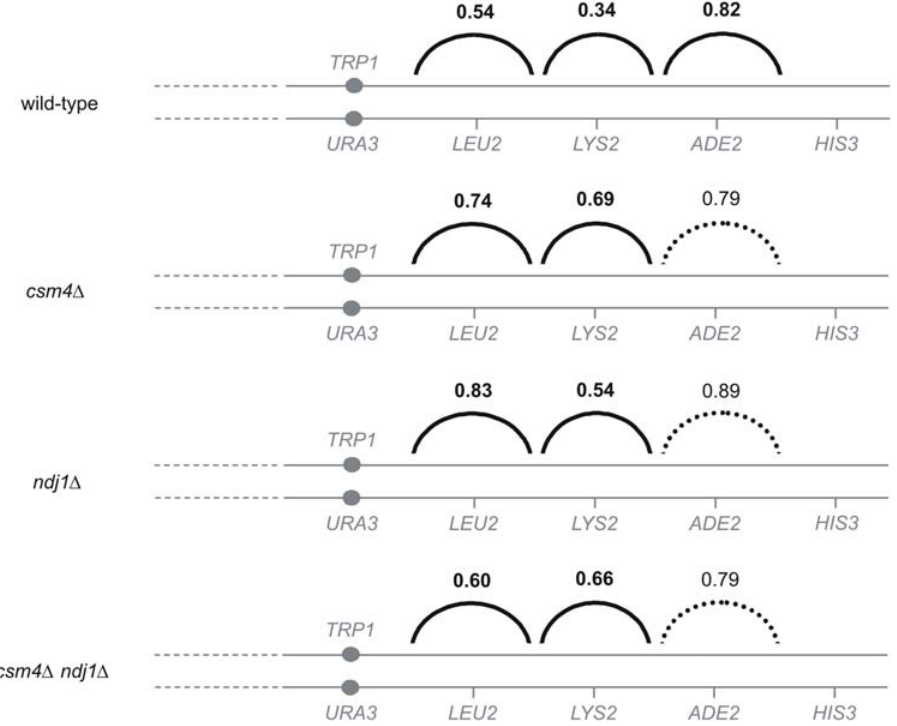
Figure 4. Crossover interference is partially disrupted in csm4 D strains on chromosome XV. Crossover interference was analyzed as described by Malkova et al. [37] and Martini et al. [34] using data obtained from the EAY1108/EAY1112 strain background (Table 1). The numbers above the solid arcs are the average of the significance interference ratios for each interval pair. n.s. and dashed arc indicates that both members of the interval pair did not show significant